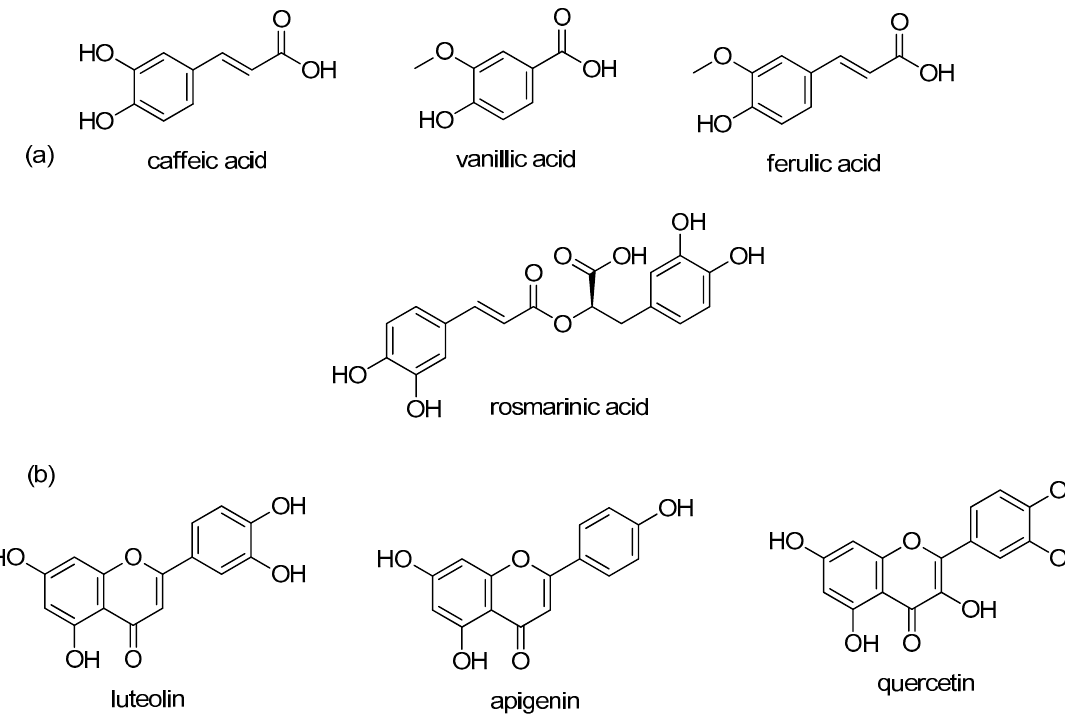
Figure 1. Major phenolic components in sage extract; ( a ) phenolic acids; ( b ) flavonoids.